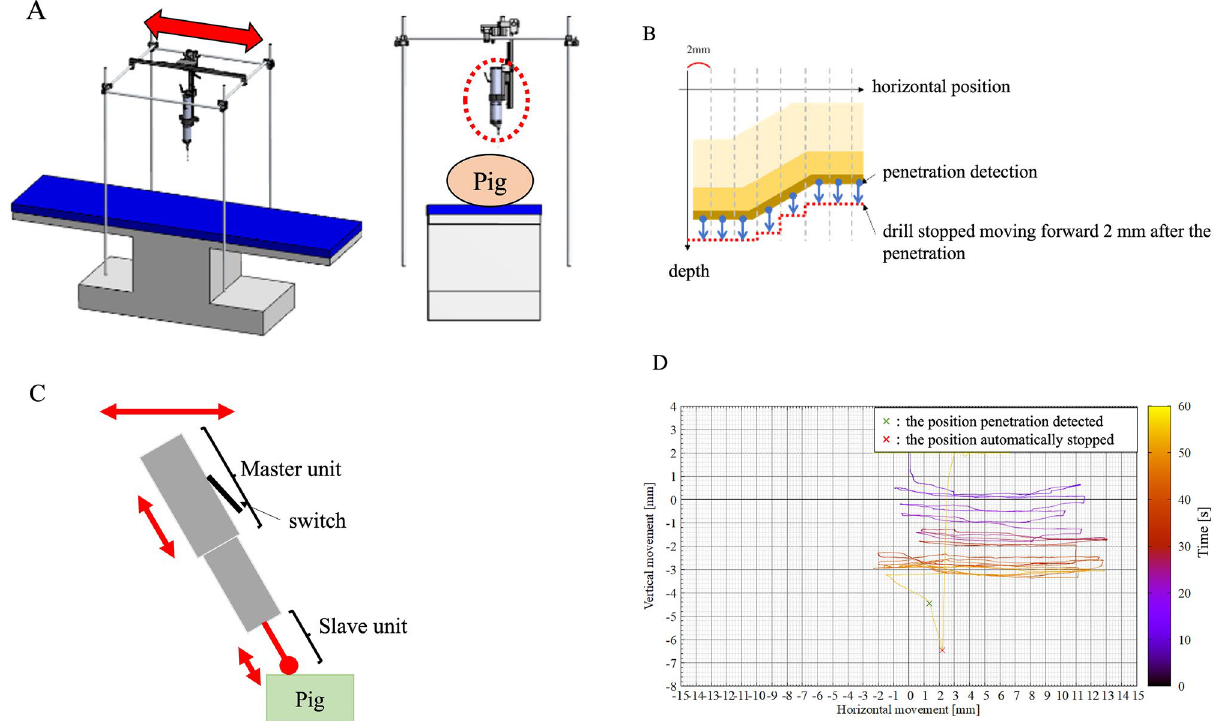
Figure 5. Schematic view of the surgical drill with a haptic interface using horizontal positional information. ( A ) Custom-made surgical table for the haptic drill in the horizontal direction. ( B ) The horizontal position was divided into 2 mm increments, and penetration detection was performed within each section. The drill stopped moving forwards 2 mm after penetration. ( C ) The surgeon horizontally operated the haptic drill installed diagonally to the spine. ( D ) Position waveform of the haptic drill using horizontal position information. The waveform colour changes from black to yellow over